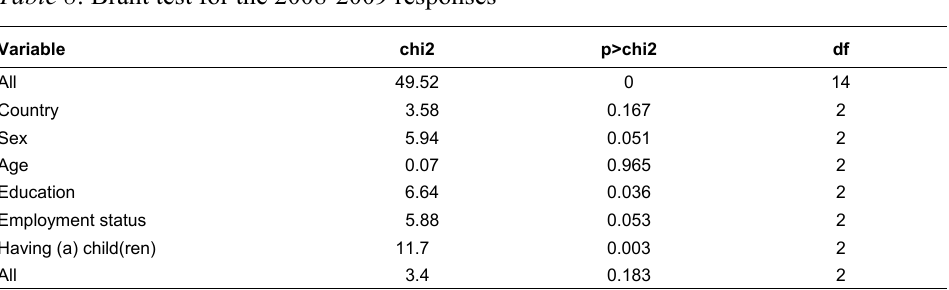
Table 8 : Brant test for the 2008-2009